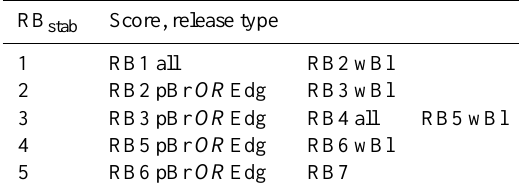
Table 3. Classification of profile stability based on the Rutschblock (RB) test result in five classes (RB stab ) based on RB score (score 1–7) and RB release type. The classification is based on the stabil- ity classification scheme by Schweizer and Wiesinger (2001)).